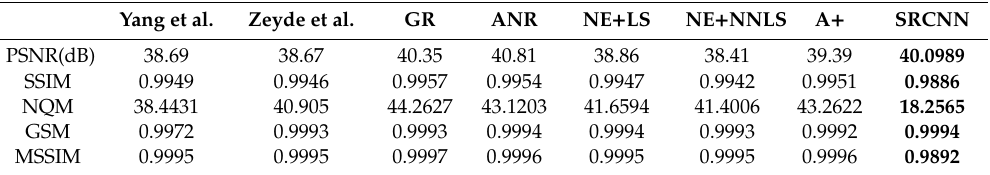
Table 3. Comparison of super-resolution results of di ff erent